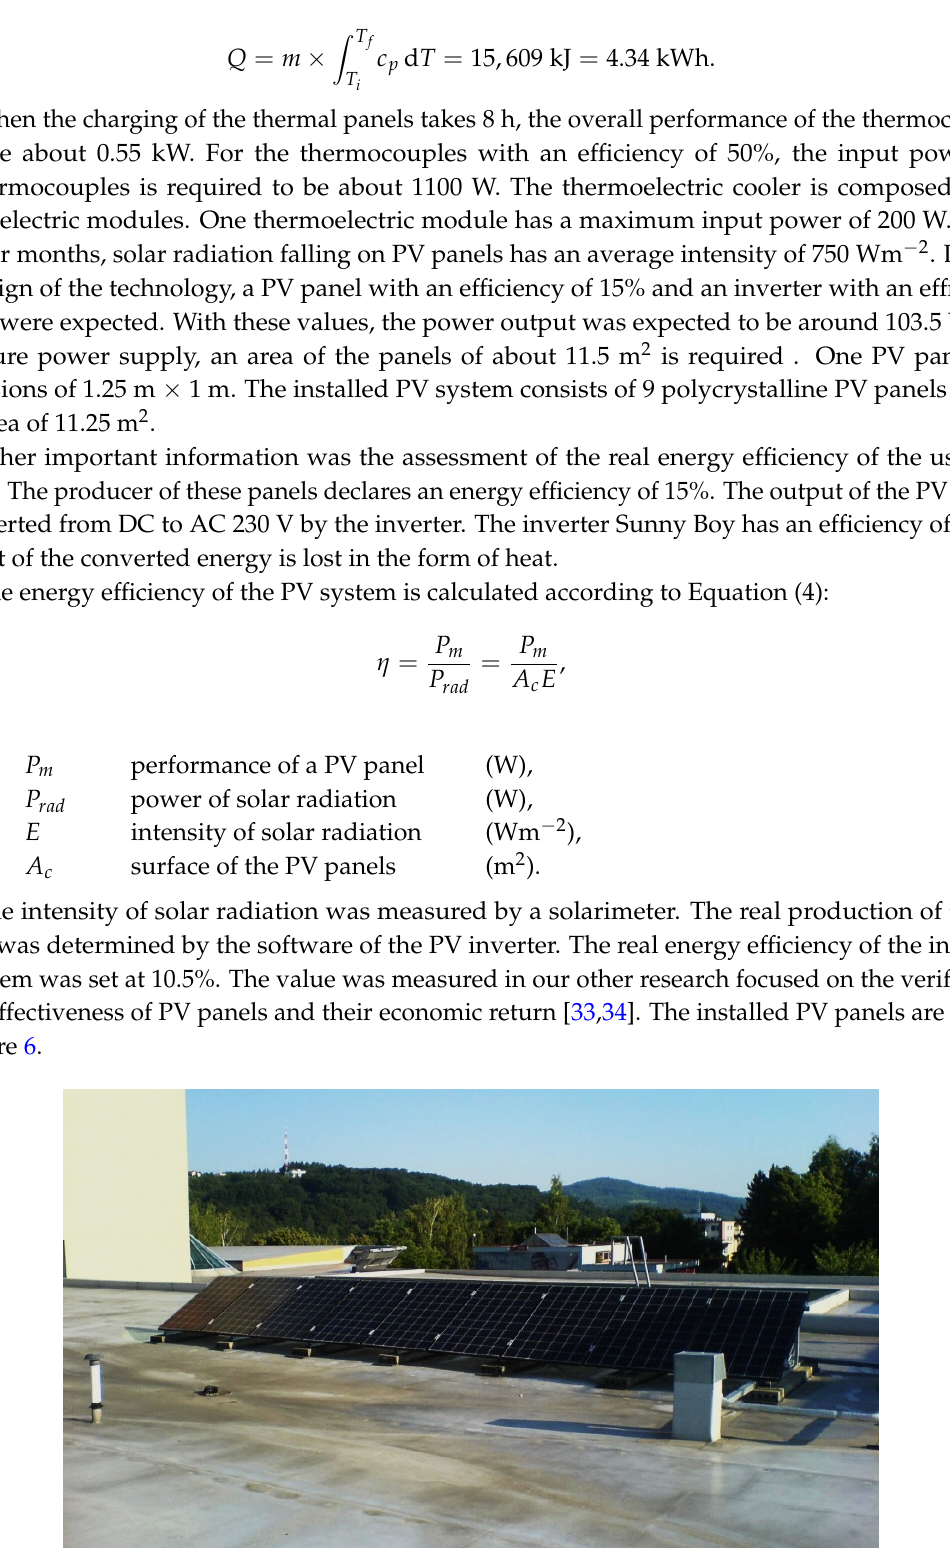
Figure 6. Photovoltaic (PV)